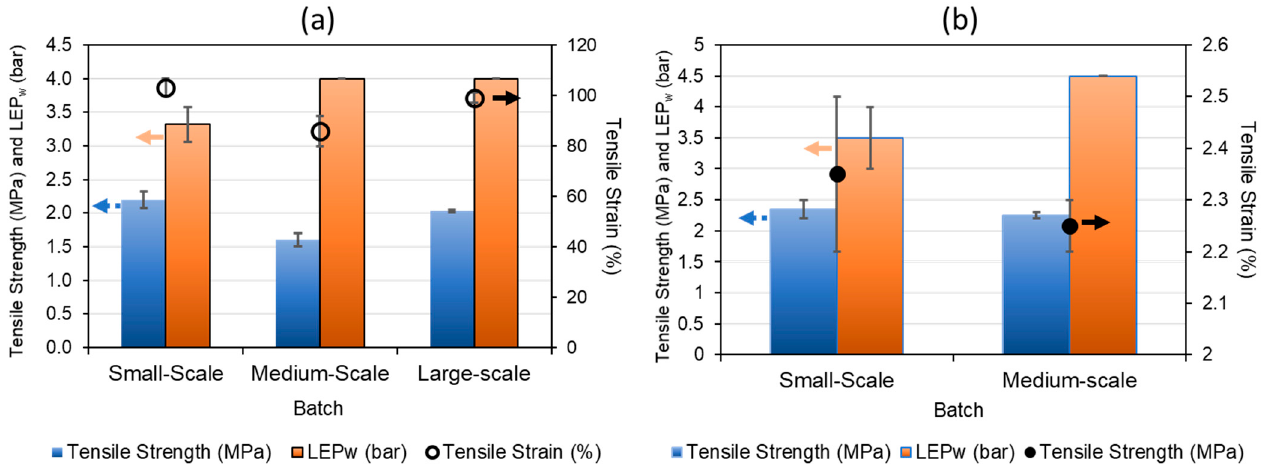
Figure 6. Tensile strength and strain and liquid entry pressure (LEP w ) of water in produced hollow fiber membranes in each batch. Small scale: 1.5 kg batch; medium scale: 20 kg batch; large scale: 50 kg. ( a ) Fibers made with PVDF 1 dope; ( b ) fibers made with PVDF 2 dope.